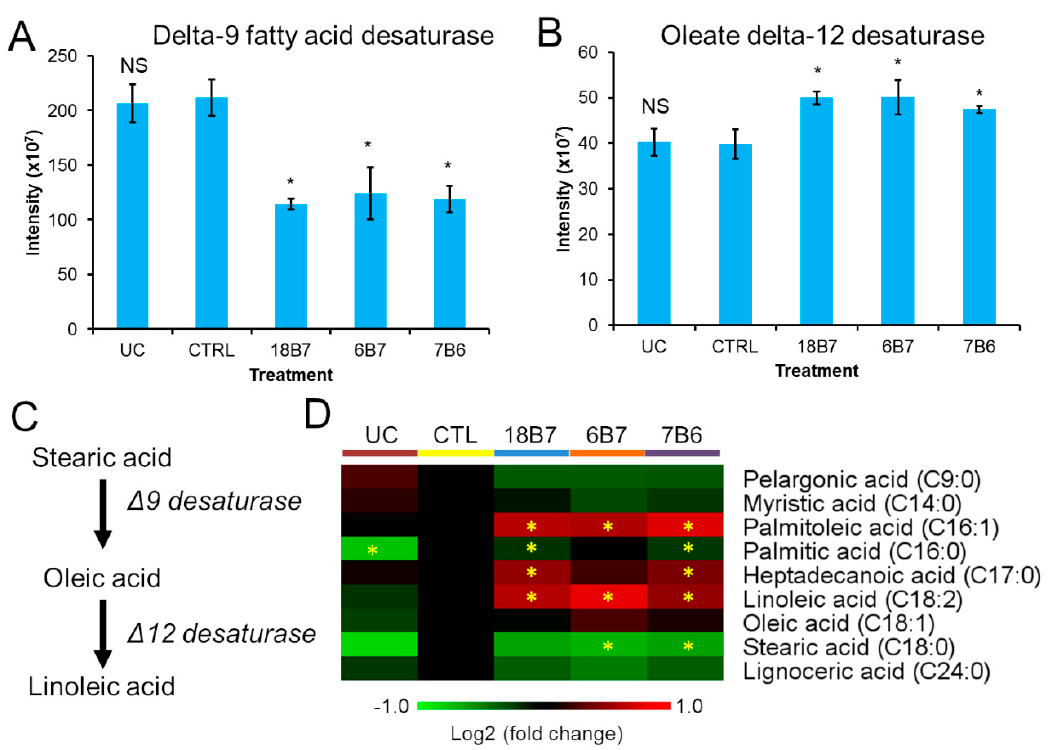
Figure 2. Effect of monoclonal antibodies on H. capsulatum unsaturated fatty acid biosynthesis. ( A,B ) Abundance profiles of delta-9 fatty acid desaturase ( A ) and oleate delta-12 desaturase in H. capsulatum cells treated with monoclonal antibodies. ( C ) Enzymes and metabolites of the unsaturated fatty acid biosynthesis pathway. ( D ) Abundance profiles of free fatty acids (not bound to complex lipids) in H. capsulatum yeast cells treated with monoclonal antibodies. Abbreviations: CTL, control; UC, untreated control without hybridoma medium; t -test: NS, not significant. * p ≤ 0.05 compared to the control sample .